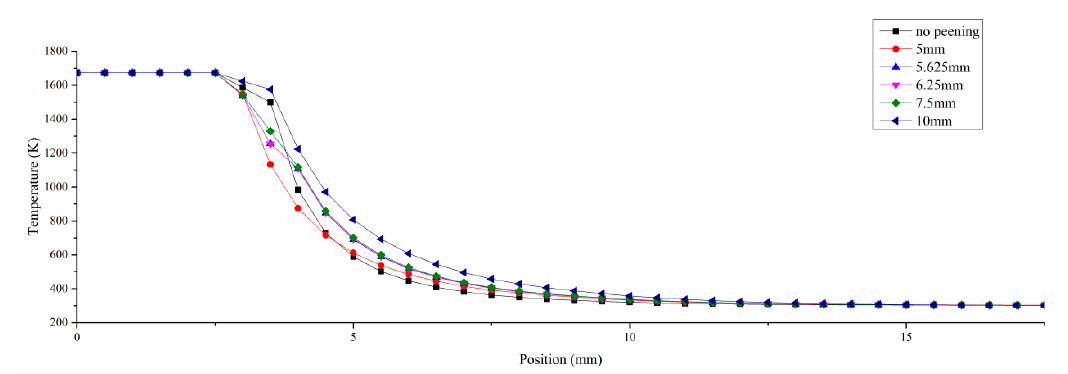
Figure 5. Temperature and angle variations at injection point.